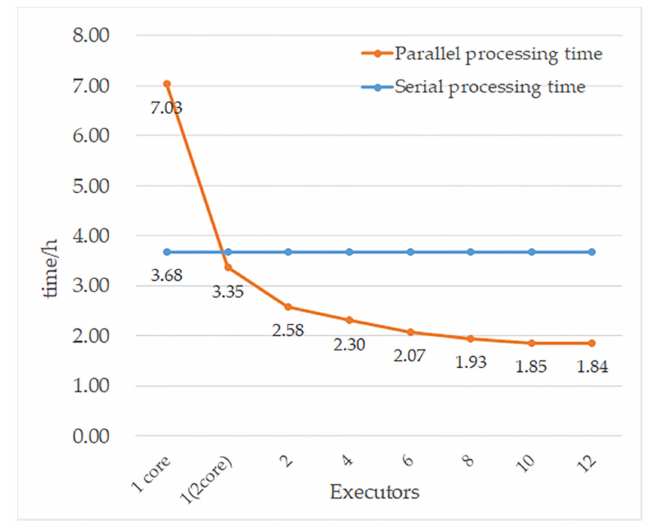
Figure 15. Comparison of filtering processing time with increasing number of executors (single cores) for the entire study area (all PATCHs): x -axis represents the number of executors. y -axis represents the filtering processing time with increasing number of